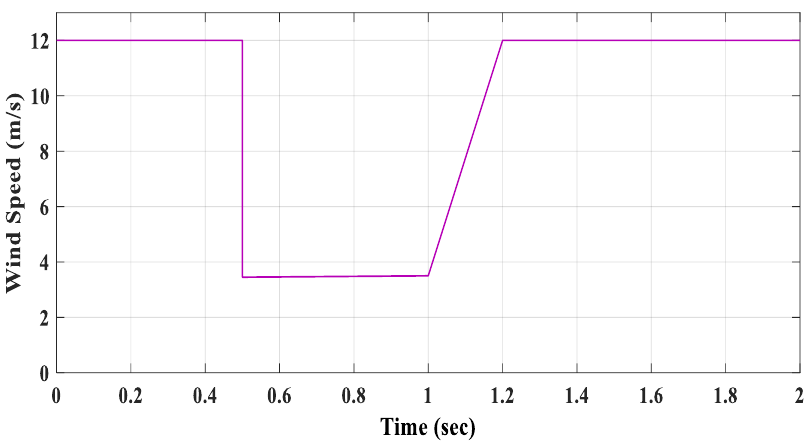
Figure 20. Wind speed input pattern for wind turbine framework.